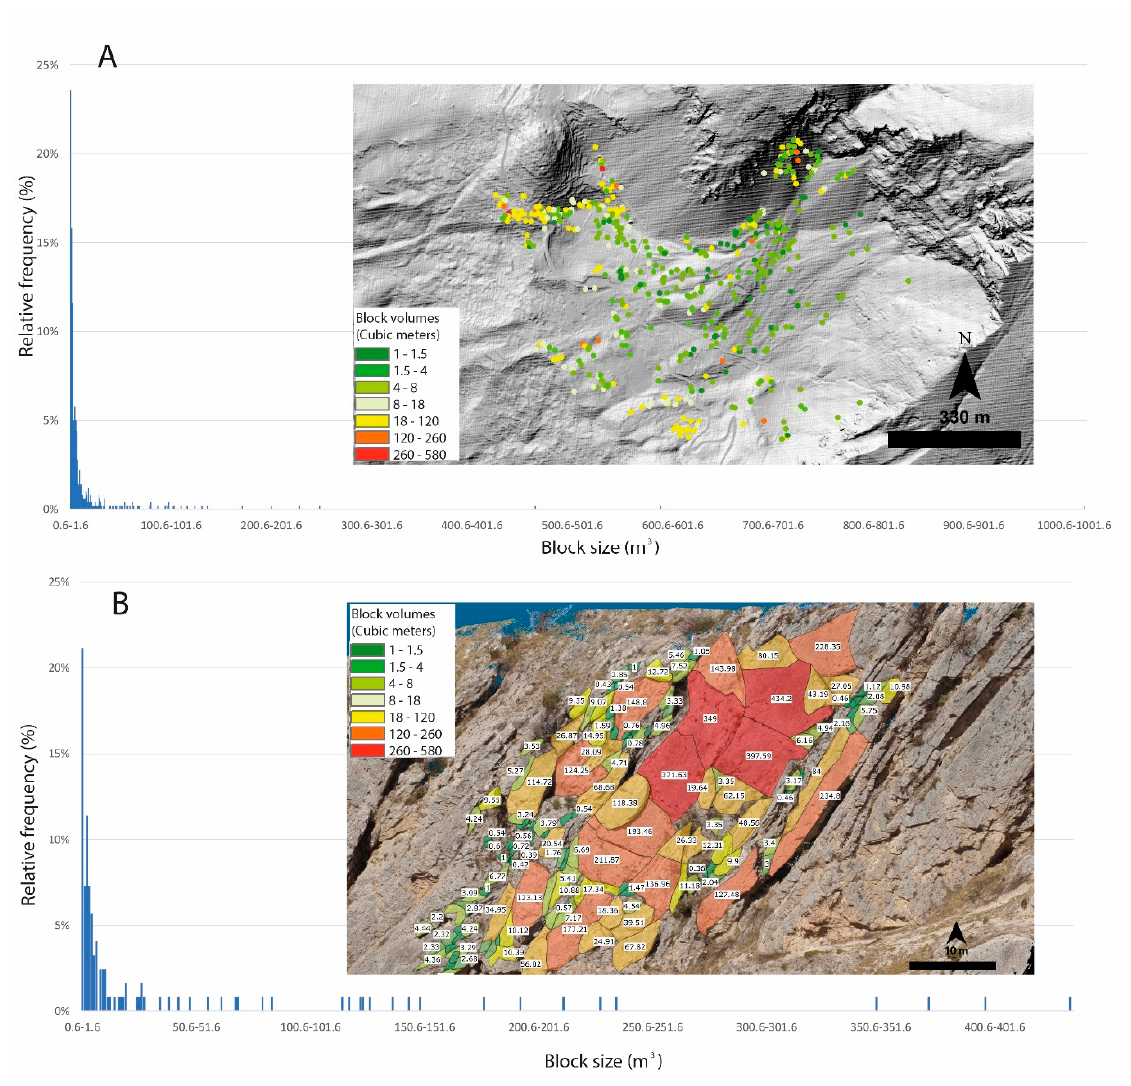
Figure 16. ( A ) Relative frequency of block volumes extracted from the map of recent rockfall events. ( B ) Relative frequency of block volumes calculated from the map of potential blocks characterizing the area UAV 2.